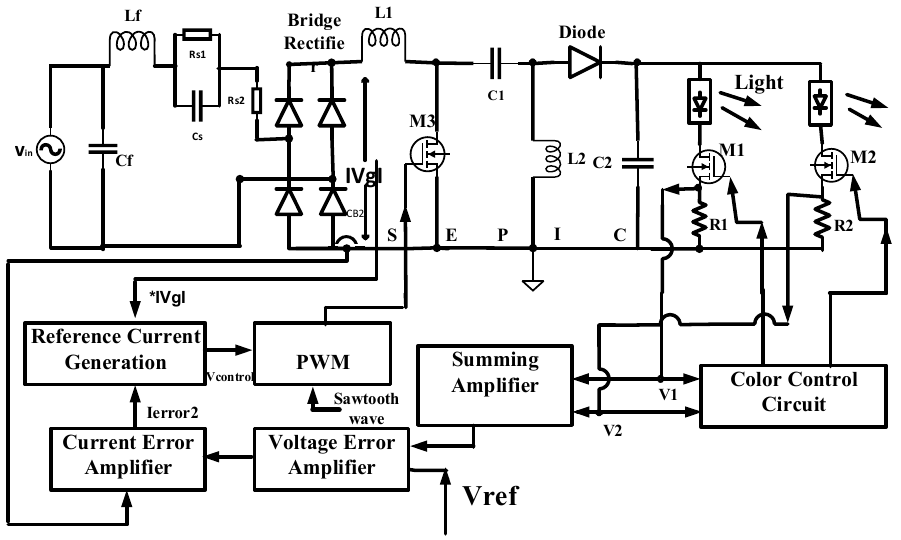
Figure 1. Power stage (basic SEPIC) and color control system.